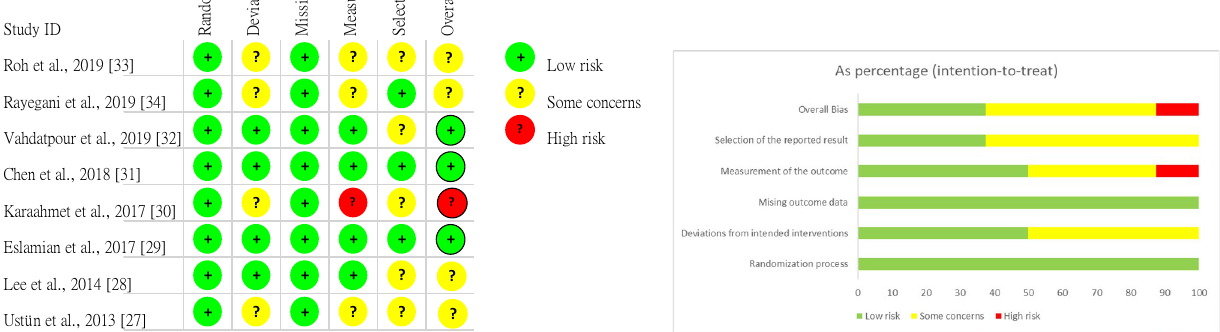
Figure 2. Study quality assessment.